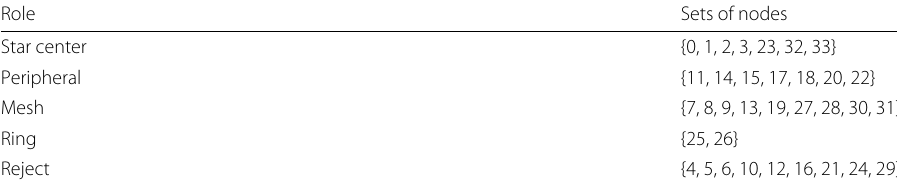
Table 3 Classification results on Zachary’s Karate Club (Zachary